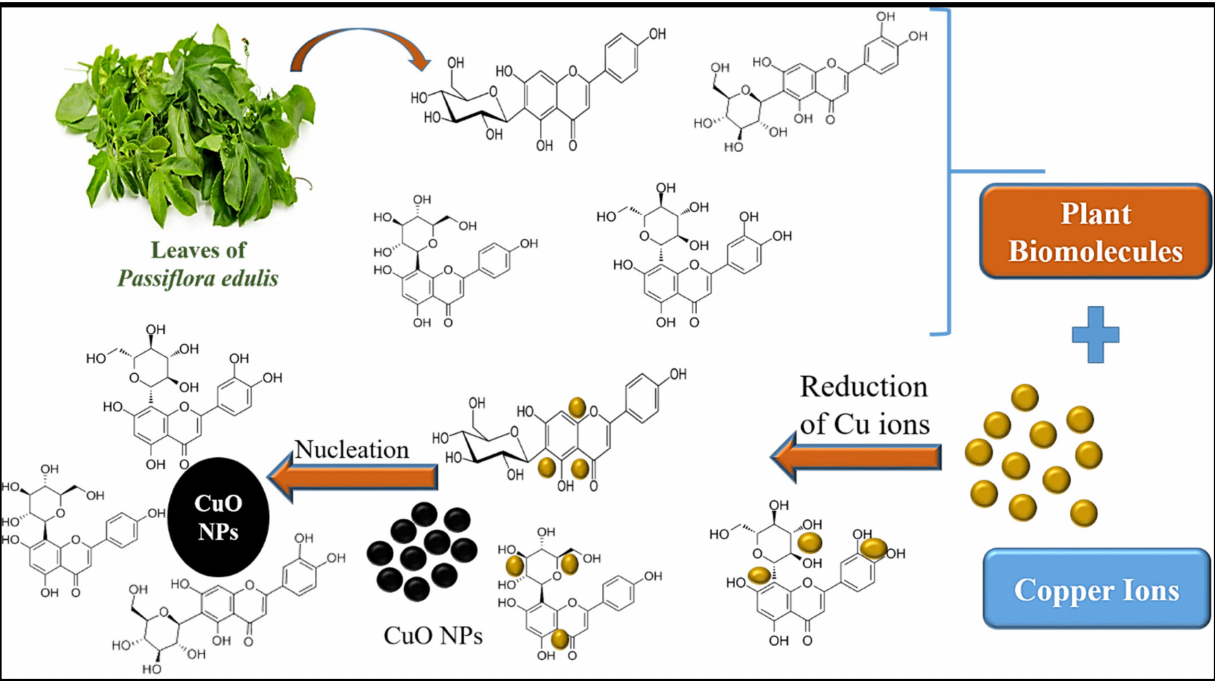
Figure 3. Role of plant